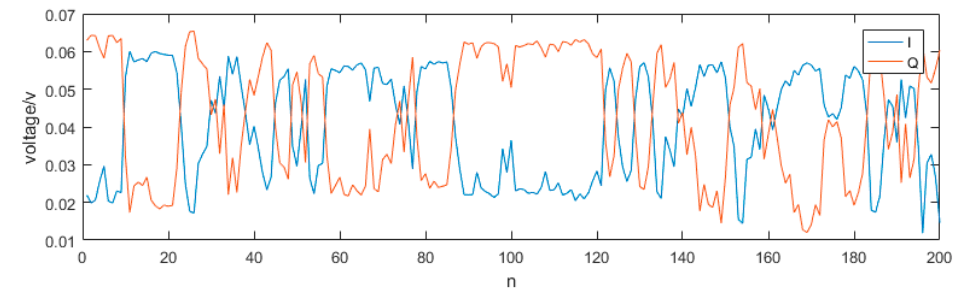
Figure 4. The reflected RF signal collected by the oscilloscope.